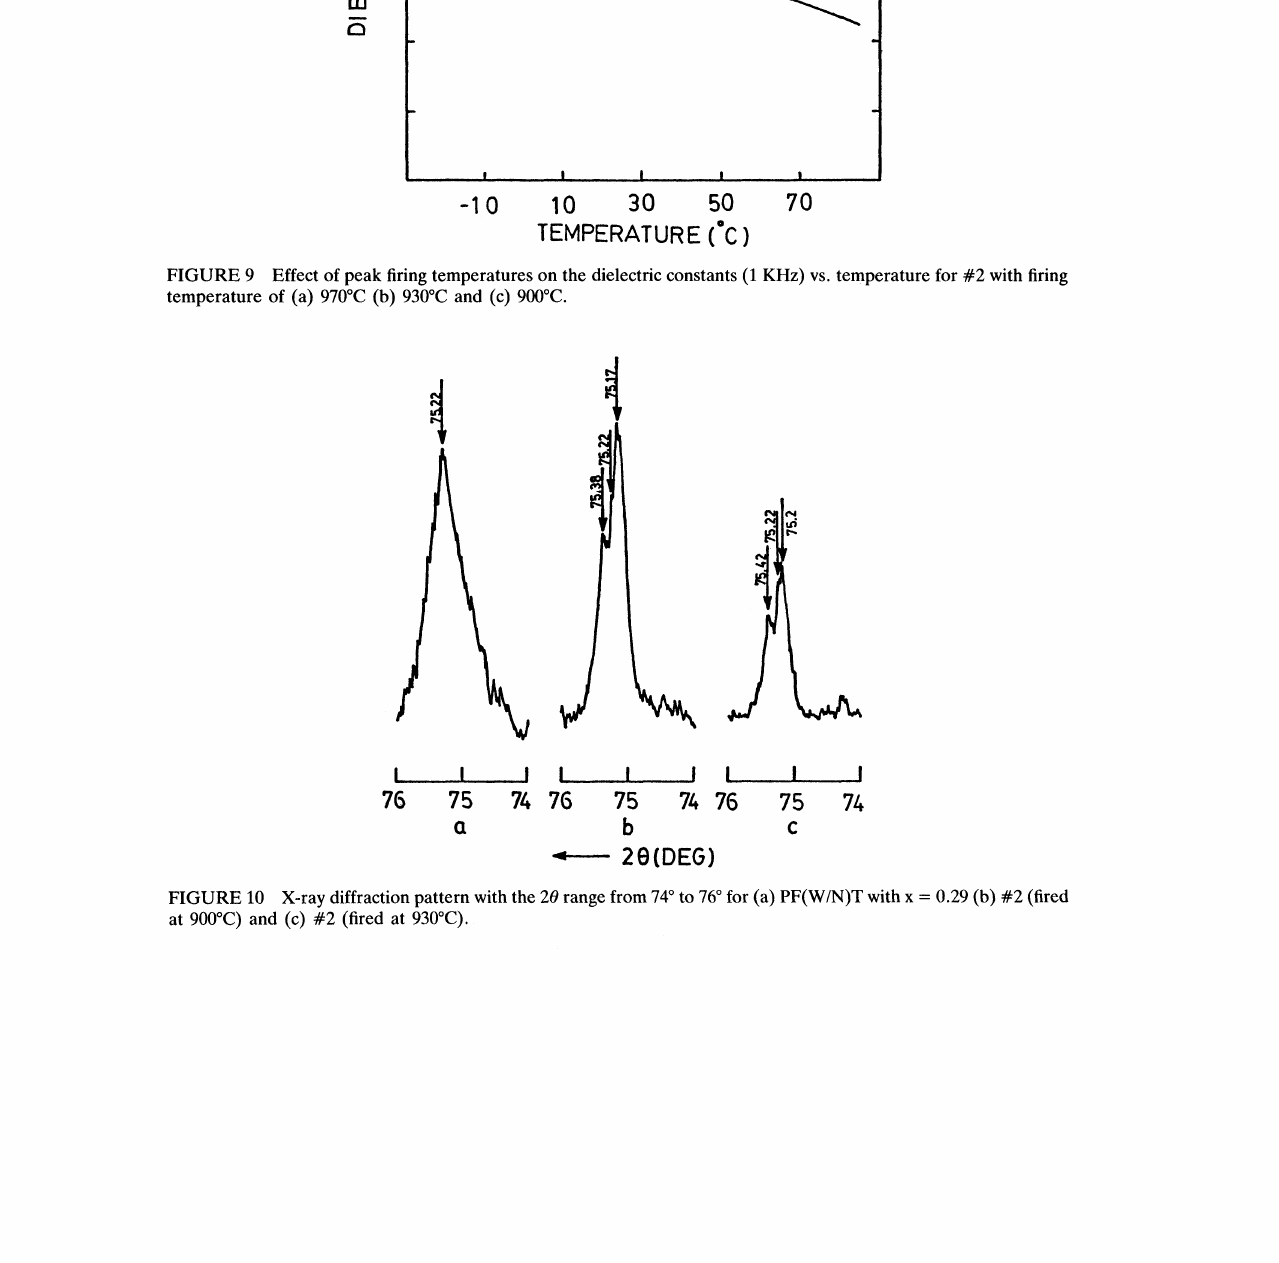
FIGURE 9 Effect of peak firing temperatures on the dielectric constants (1 KHz) vs. temperature for #2 with firing temperature of (a) 970C (b) 930C and (c) 900C.